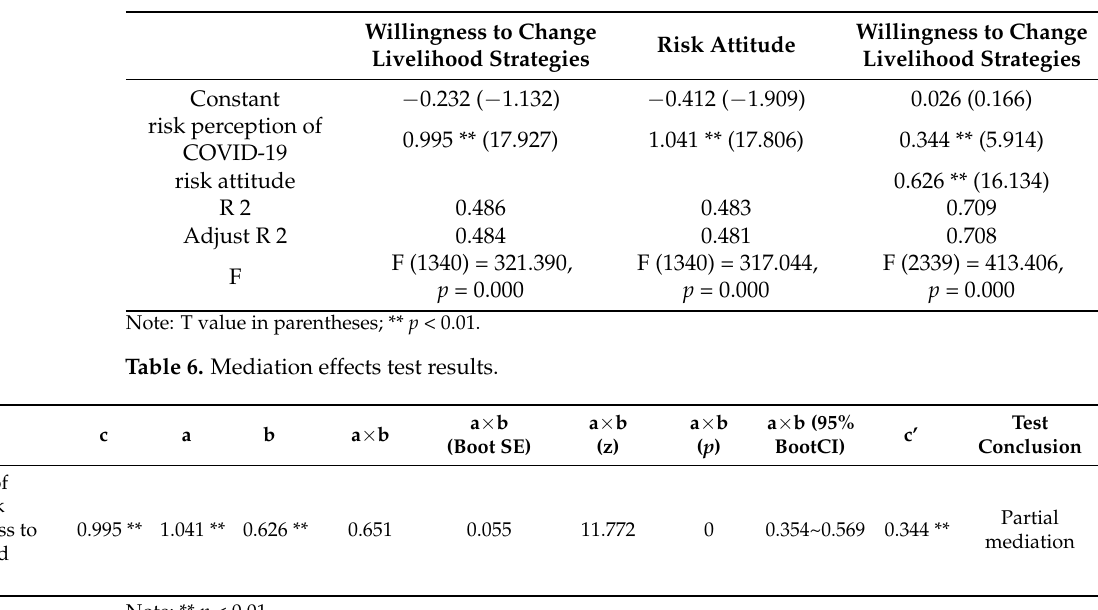
Table 5. Mediation effects model tests.